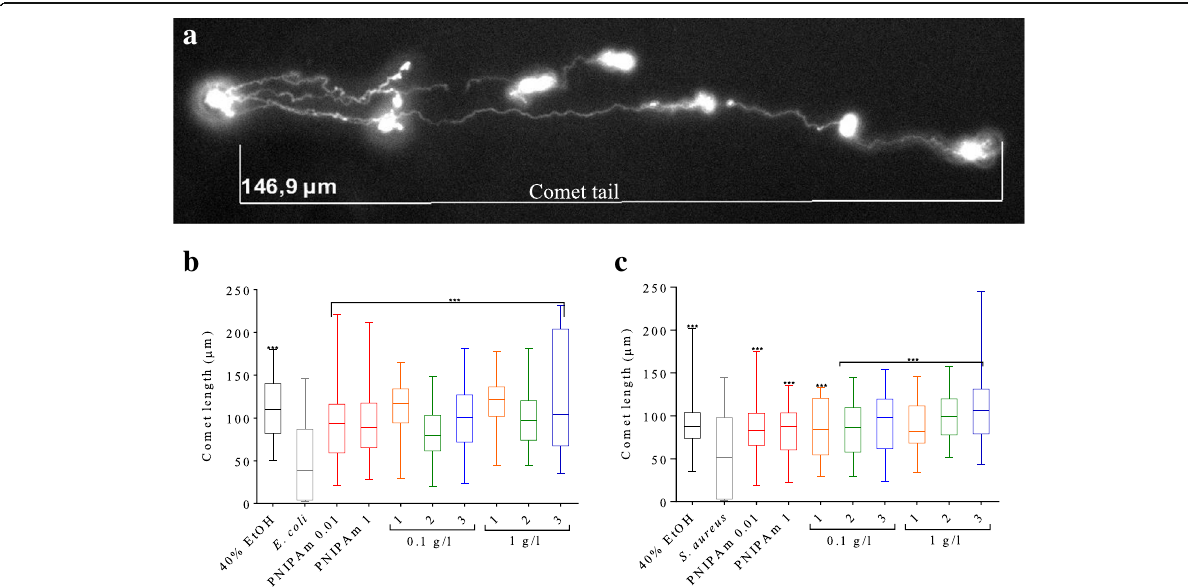
Fig. 4 An example of an Escherichia coli comet tail , following treatment with Fe 3 O 4 -PNIPAAm-3 ( a ). Results of DNA strand breaks (length of comet tail) for Escherichia coli ( b ) and Staphylococcus aureus ( c ) incubated for 30 min with 40% EtOH (positive control), without nanocomposites (negative control), PNIPAAm (0.1 and 1 g/l), and (1) Fe 3 O 4 -PNIPAAm-1, (2) Fe 3 O 4 -PNIPAAm-2 and (3) Fe 3 O 4 -PNIPAAm-3 (error bars represent SD for comet length of 50 cells). Significance level *** P < 0.001